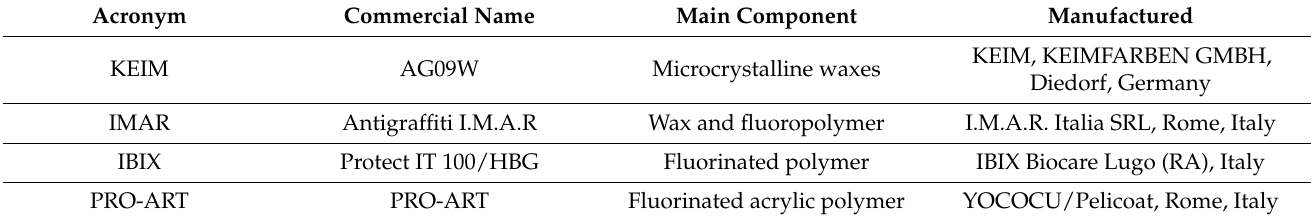
Table 2. List of protective